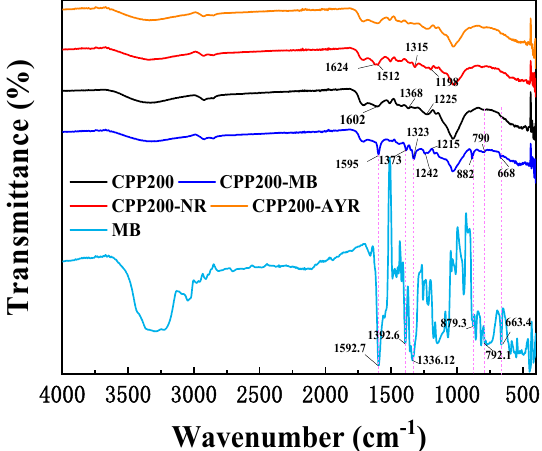
Figure 9. FT − IR spectra of CPP200 pre-and post-adsorption of MB, AYR and NR.